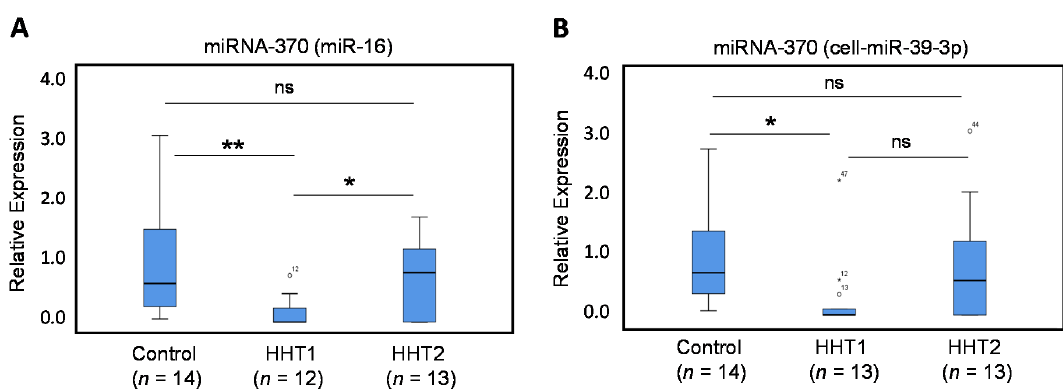
Figure 1. Quantitative Reverse Transcriptase–Polymerase Chain Reaction (qRT-PCR) of miRNA-370. Total plasma RNA was isolated from HHT1 and HHT2 patients and control subjects. Relative expression levels of miR-370 were measured by qRT-PCR using miR-16 ( A ) or cel-miR-39-3p ( B ) as normalizers. The number of samples analyzed is indicated in parentheses. Symbols outside the box plot represent extreme values ( ◦ ) and outliers (*) with their corresponding sample numbers. Experiments were performed in triplicates. (* p < 0.05; ** p < 0.01; ns, not significant).